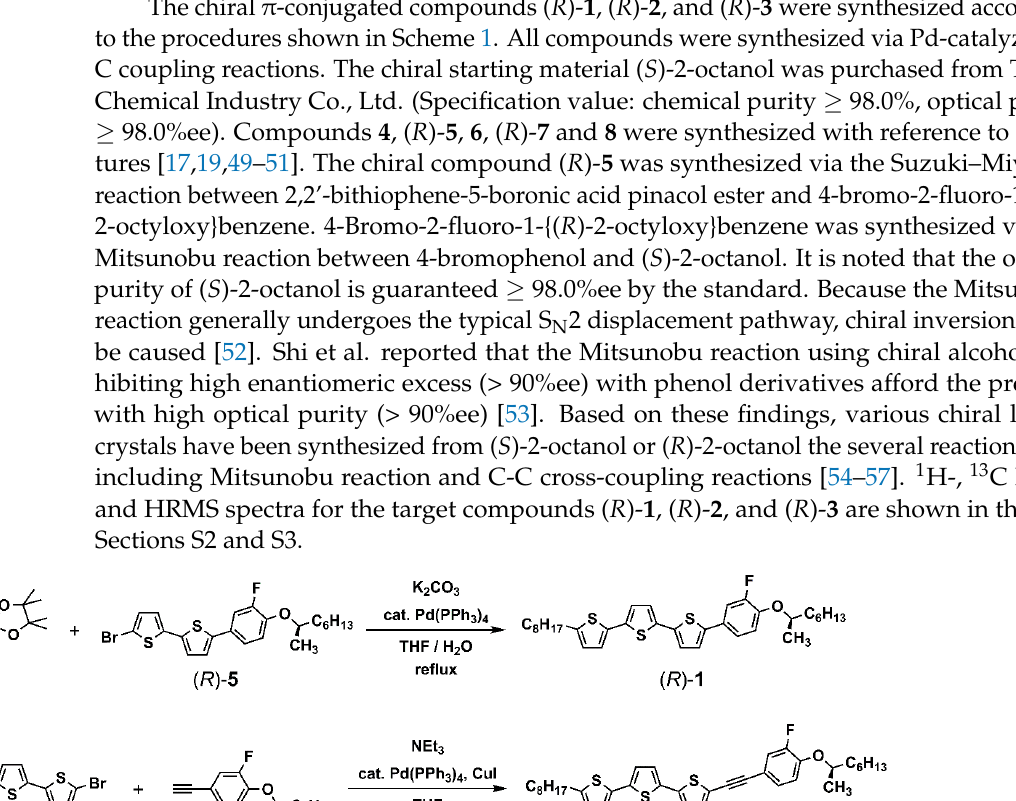
Figure 1. Chemical structures of the chiral π -conjugated compounds ( R )- 1 , ( R )- 2 , and ( R )- 3